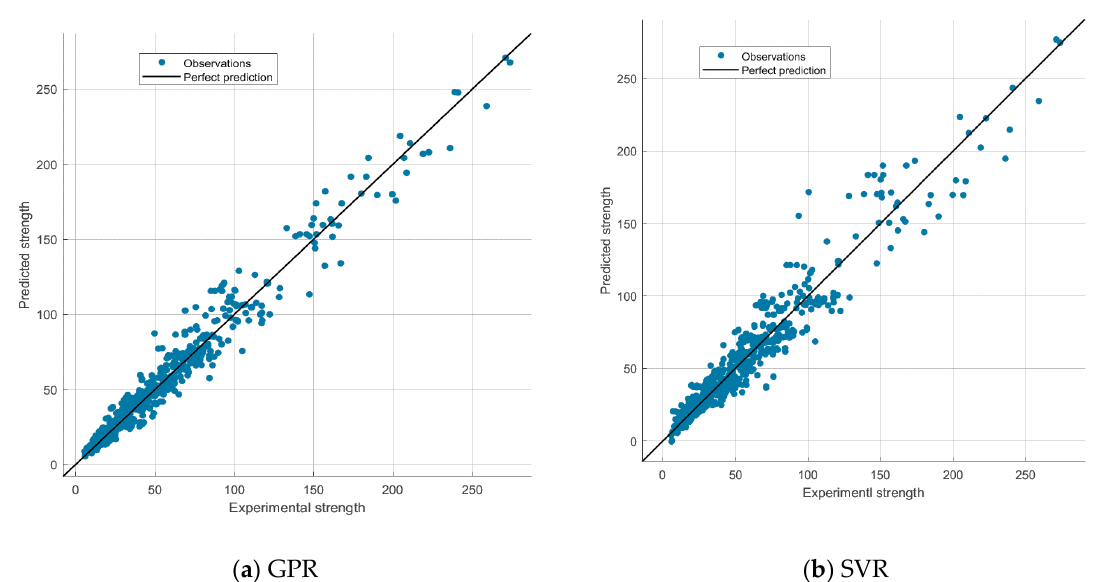
Figure 4. Plot of predicted tensile strength (kN) against experimentally observed strength (kN) using the training datasets. ( a ) GPR; ( b ) SVR.